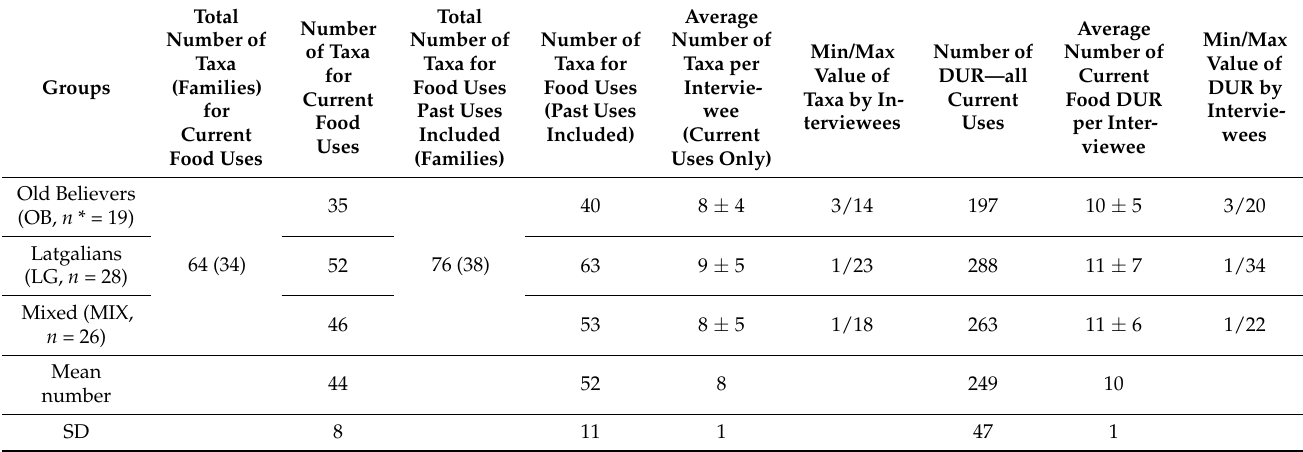
Table 3. Quantitative comparison of taxa and uses between and within the groups.